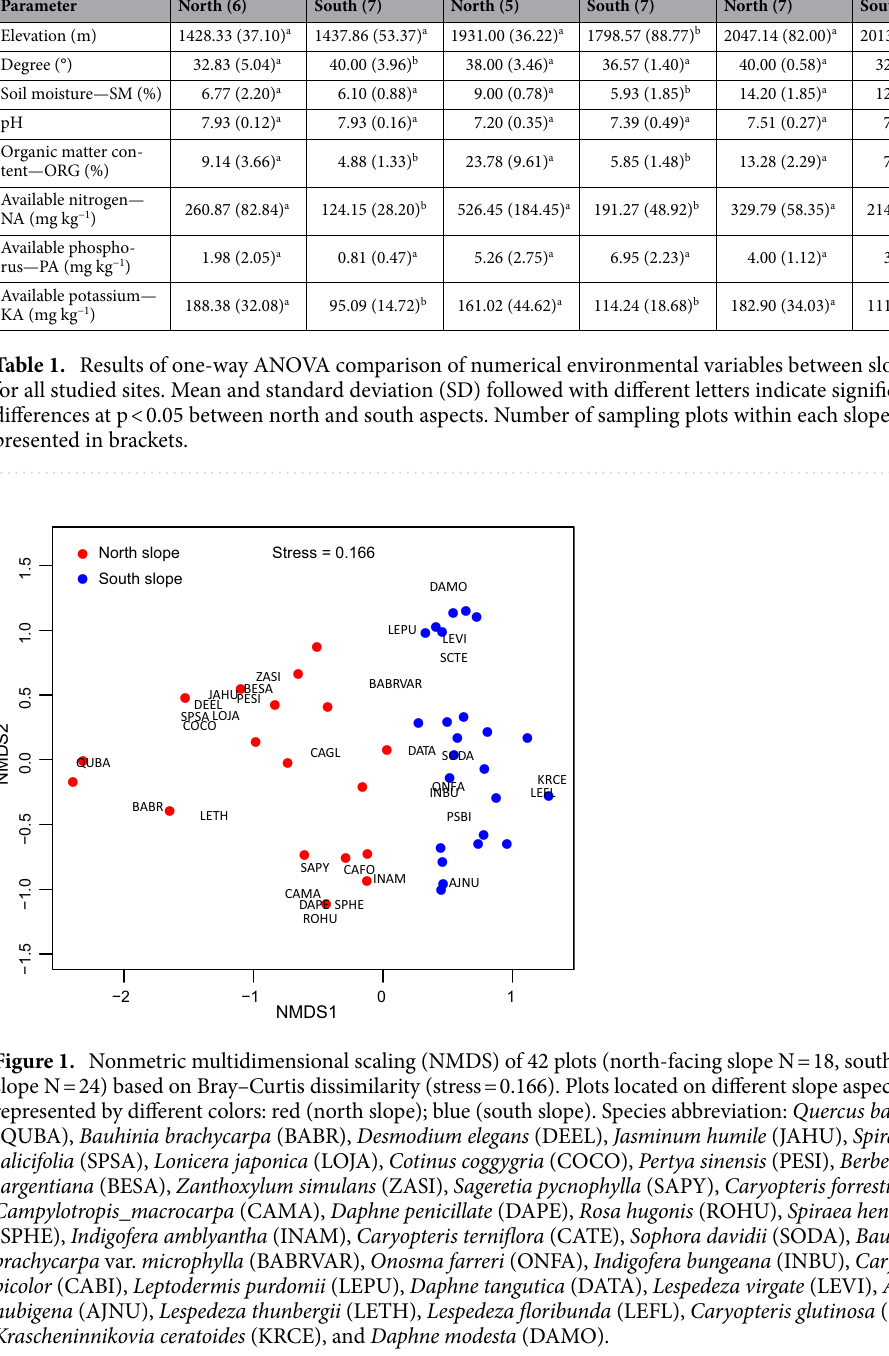
among sites, where the significantly higher density was on the south-facing slope at Feihong but on north-facing slopes at Shidaguan and Wenchuan (Table 2, Fig. 2e). The between-aspect vegetation differences varied among sites, with Shidaguan showing the highest difference in biomass and height and lowest difference in density and coverage as compared to the other two sites (Table 2, Fig. 2). Biodiversity pattern. A total of 44 and 20 woody species were recorded on north- and south-facing slopes, respectively. Sample-based rarefaction showed significantly higher species richness (γ diversity) on north- than south-facing slope for all sampling efforts (Fig. 3). Both Chao2 and Jackknife2 showed higher estima- tion of species diversity on north-facing slope (Chao2 north = 63.95 ± 15.55 and Jackknife2 north = 64.49 ± 8.83 vs. Chao2 south = 31.98 ± 16.44 and Jackknife2 south = 28.50 ± 3.16).